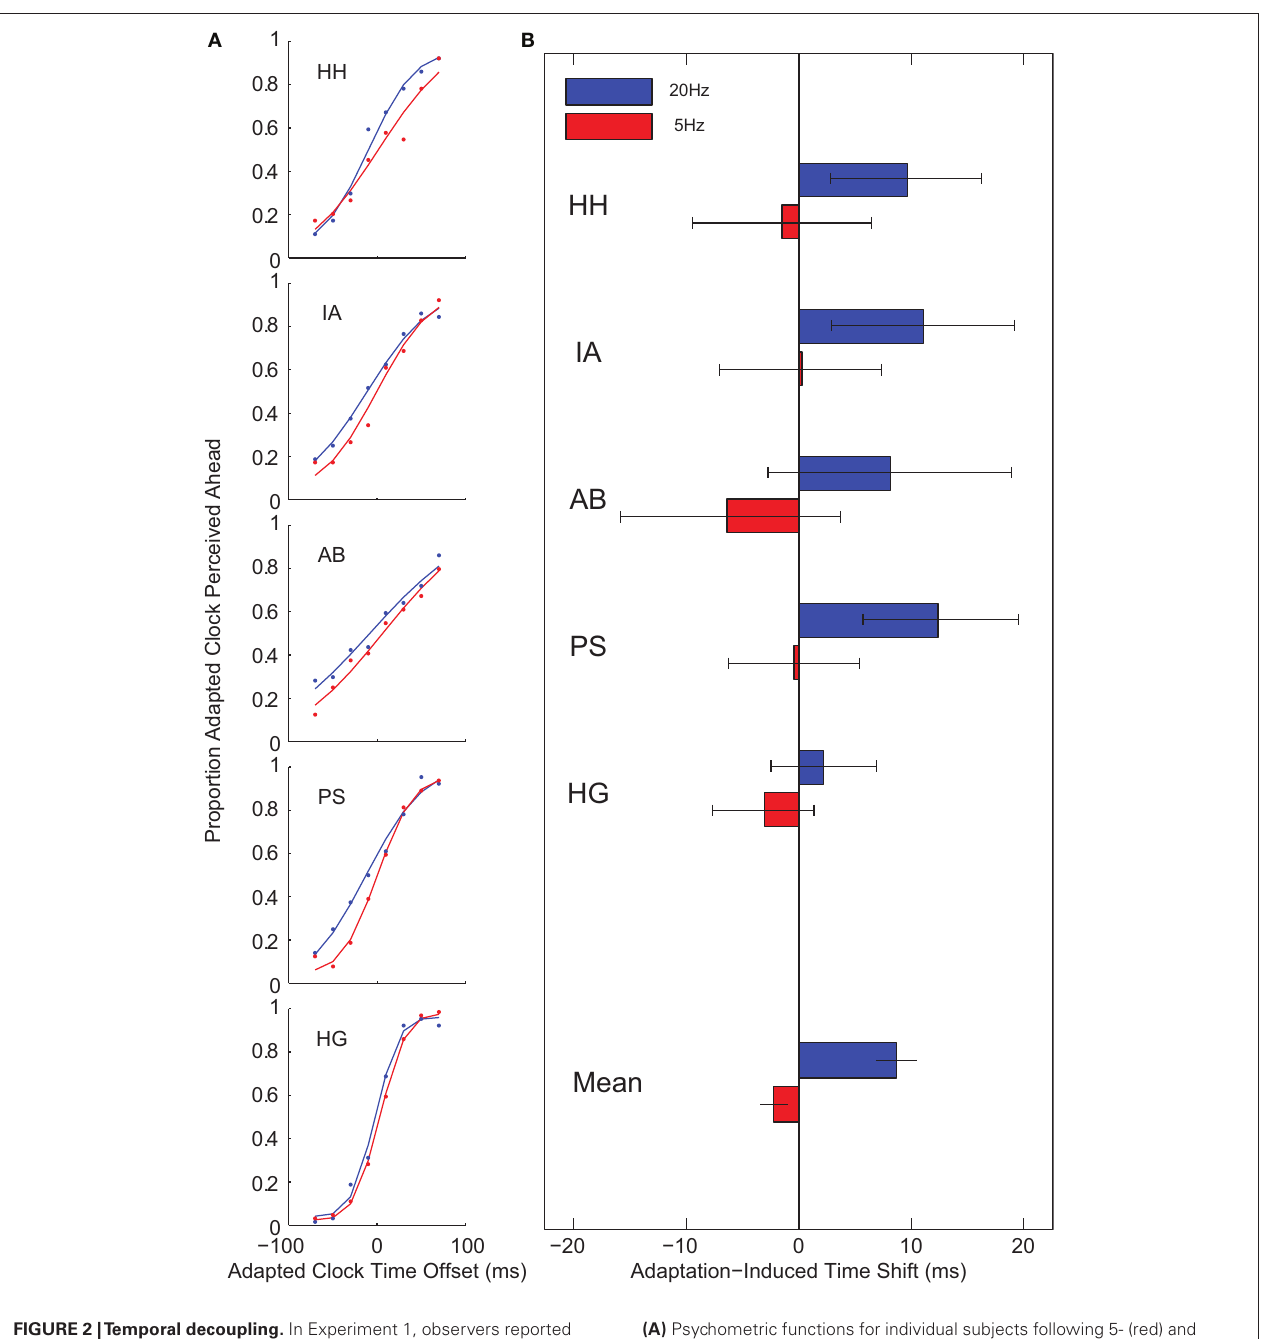
Figure 2 | Temporal decoupling. In Experiment 1, observers reported which of two clocks appeared to be more advanced. A 20-Hz adaptation caused a clock in an adapted region to appear shifted forward in time by about 10 ms. No such effect was observed for 5-Hz adaptation.